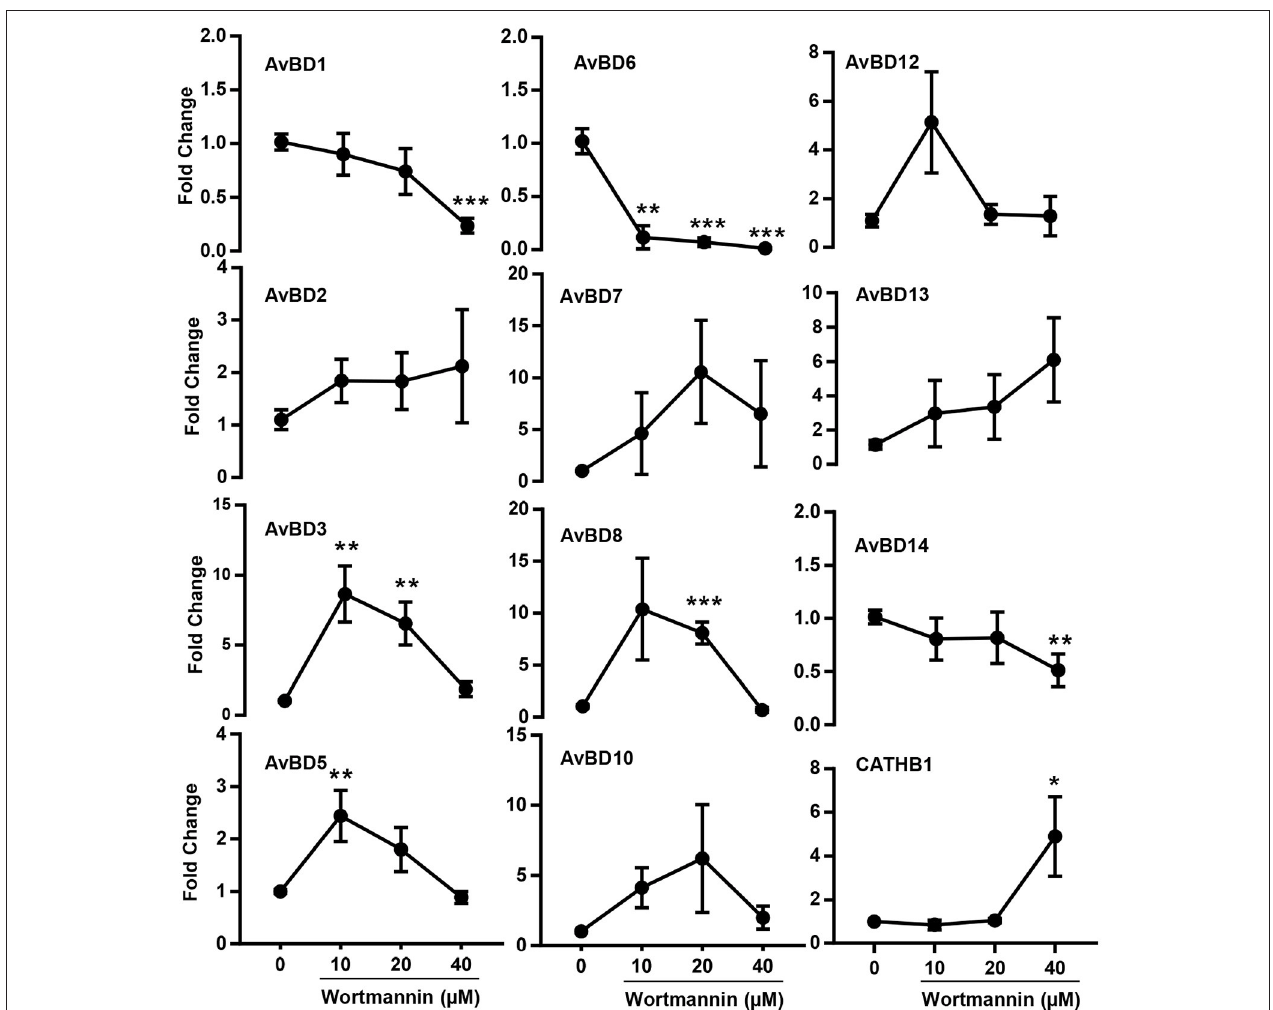
FIGURE 7 | Dose-dependent changes in multiple chicken HDP mRNA expression levels in HTC cells by wortmannin. Chicken HTC cells were treated with or without three different concentrations of wortmannin for 24h, followed by RT-qPCR analysis of mRNA expression of all chicken HDP genes that can be detected in HTC cells. The results are means ± SEM of three independent experiments. * P < 0.05, ** P < 0.01 and *** P < 0.001 (by unpaired Student’s t